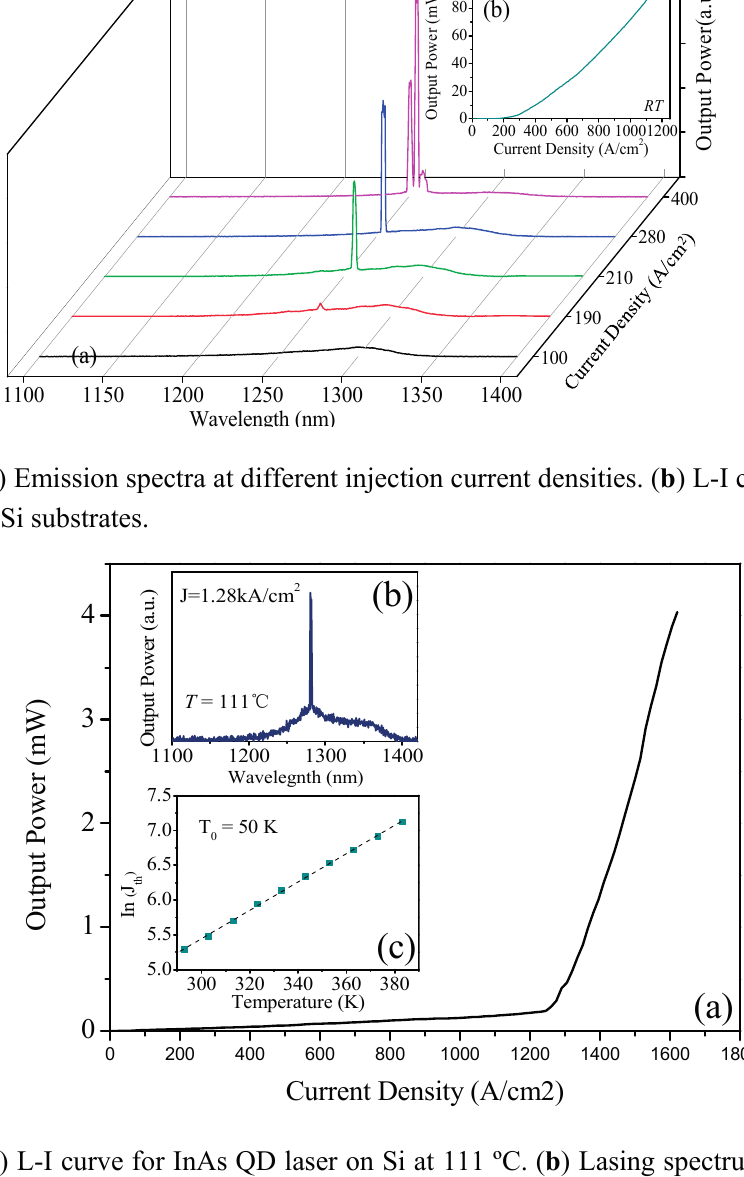
Figure 5. ( a ) L-I curve for InAs QD laser on Si at 111 ºC. ( b ) Lasing spectrum just above the threshold at 111 ºC. ( c ) Temperature dependence of the threshold current density under pulsed